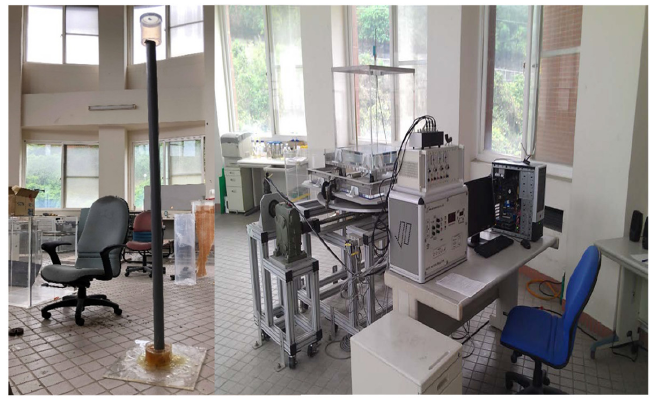
Figure 5. The simple experimental set up of OWT with a tuned liquid damper (TLD) on top. Figure 6. The simple experimental set up of OWT with a tuned liquid damper (TLD) on